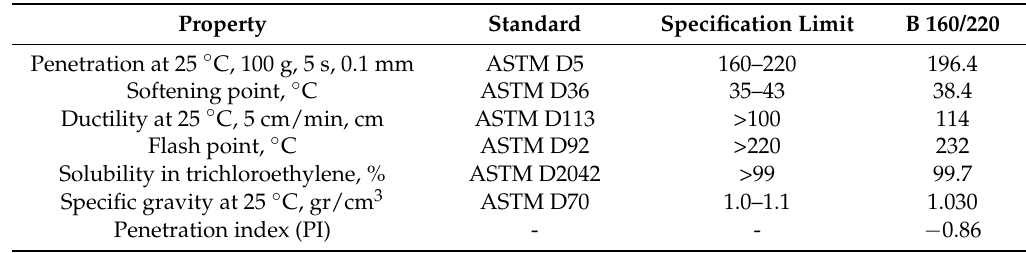
Table 1. The physical properties of the neat bitumen.